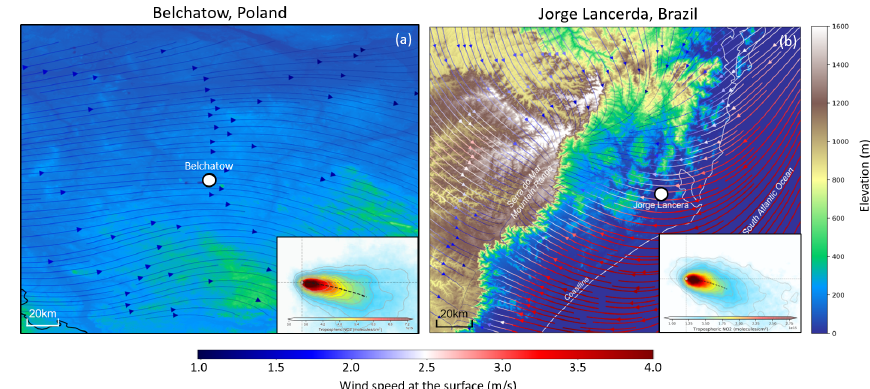
Figure 9. (a) Average 2018 surface wind fields from the ERA5 reanalysis, including topography from the Copernicus GLO-30 digital elevation model for (a) Belchatow in Poland and (b) Jorge Lacerda in Brazil. The insets in panels (a) and (b) show the wind-rotated tropospheric NO 2 columns from TROPOMI, using data from May 2018 to December